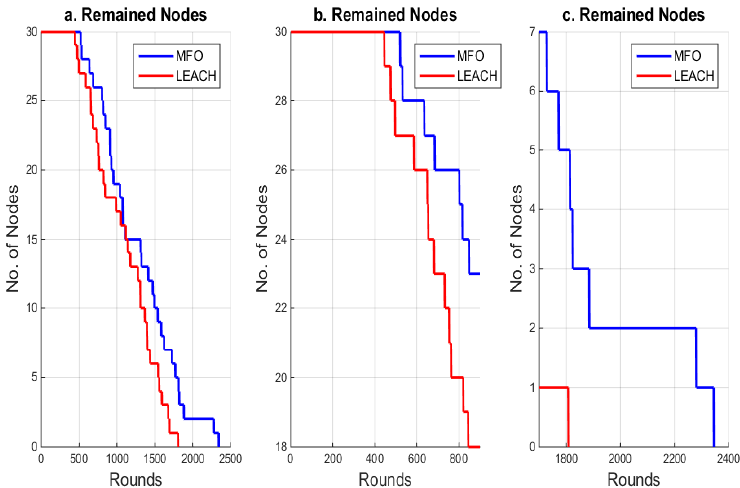
Figure 7 . The number of rounds versus the number of alive nodes in MFO and LEACH.